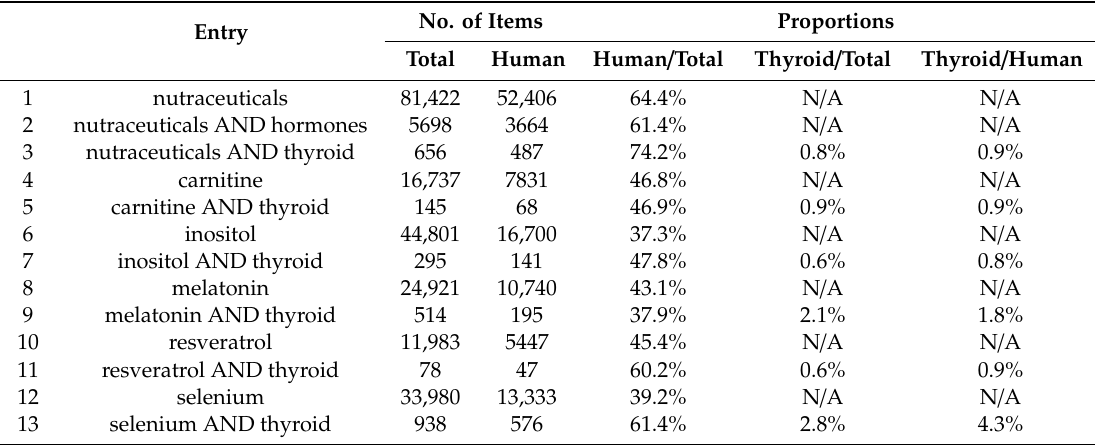
Table 2. Summary of number of articles on given nutraceuticals retrievable on PubMed as of 9 July 2019.